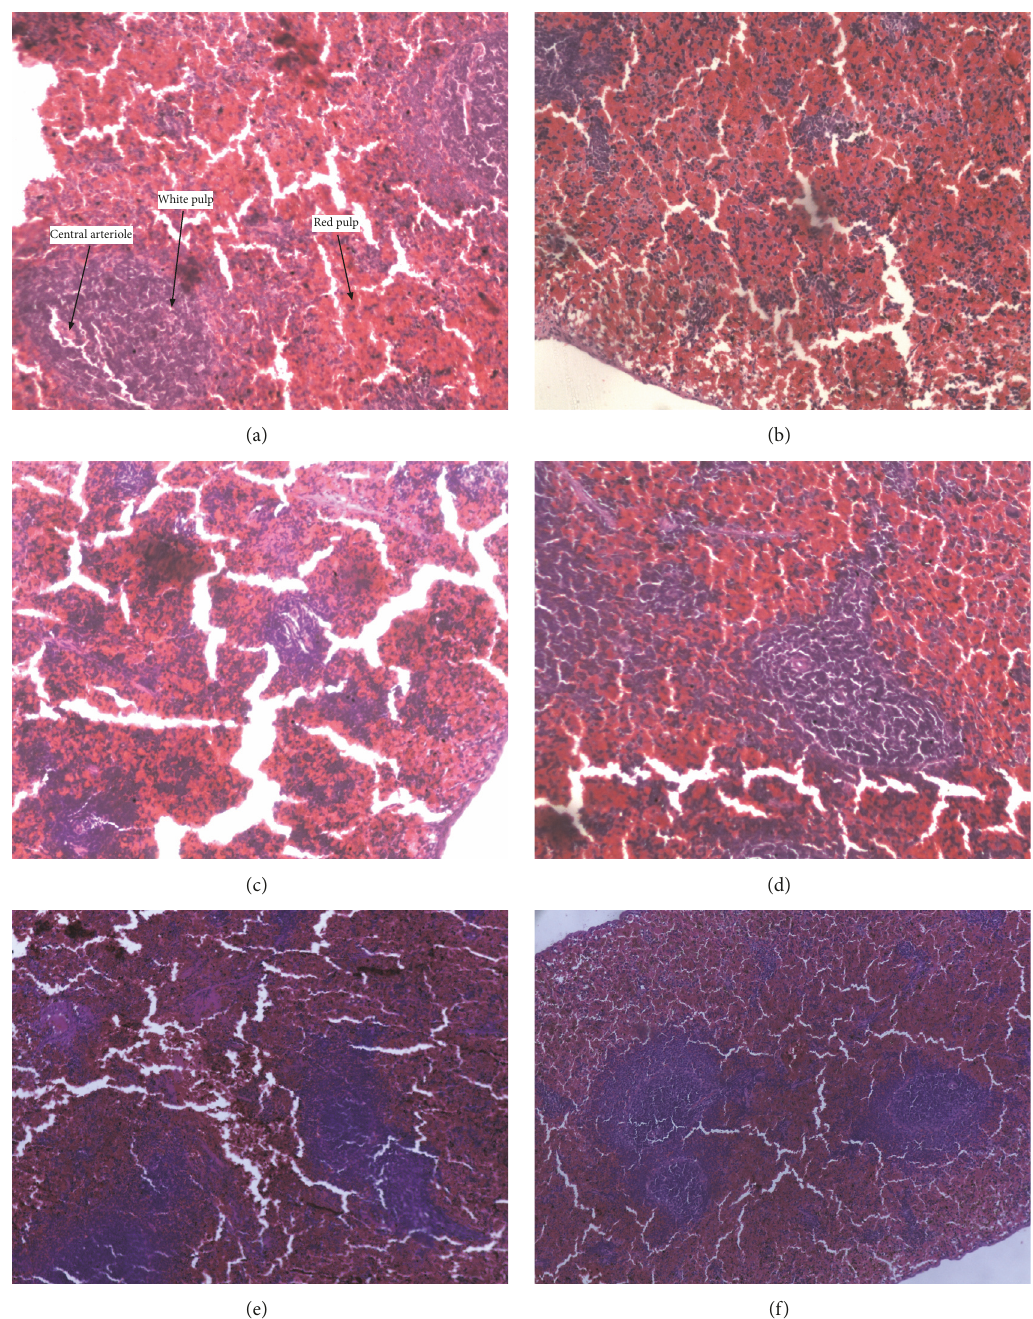
Figure 4: Photomicrograph of the sections of the spleen in control rats (a) and rats treated orally with 30 mg kg −1 (b), 100 mgkg −1